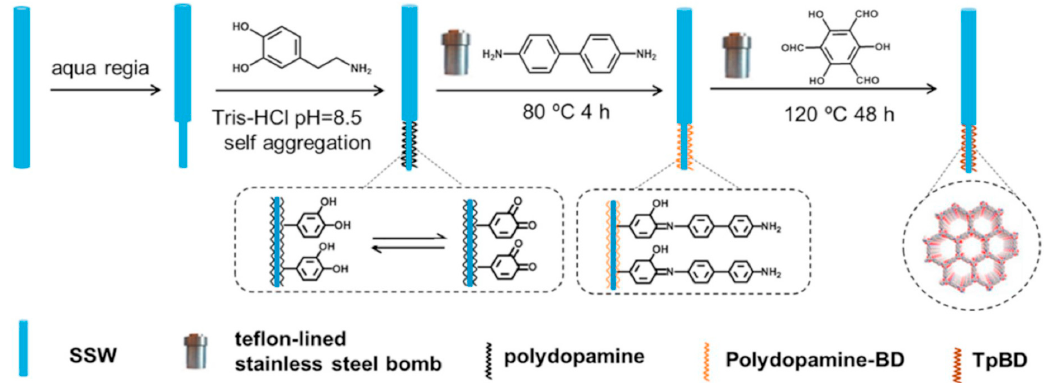
Figure 8. Fabrication of a Tp/BD COF bonded SPME fiber. Reprinted from [104] with the permission of Elsevier.